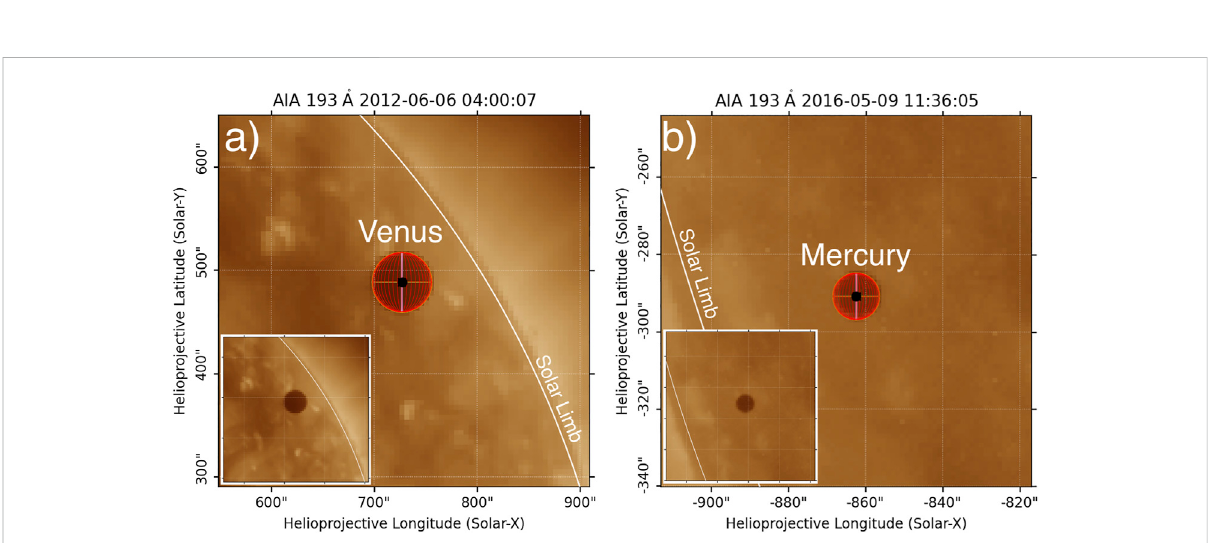
FIGURE 5 Two examples of the geometrical fi tting to bodies in the solar system with known locations and dimensions. Panel (A) shows the Venus transit on6June2012,andPanel (B) theMercurytransiton9May2016,asviewedbyAIAat19.3 nm.The fi ttedellipsoidtotheplanetsisshownwiththered mesh. The insert images show the AIA observations without the fi